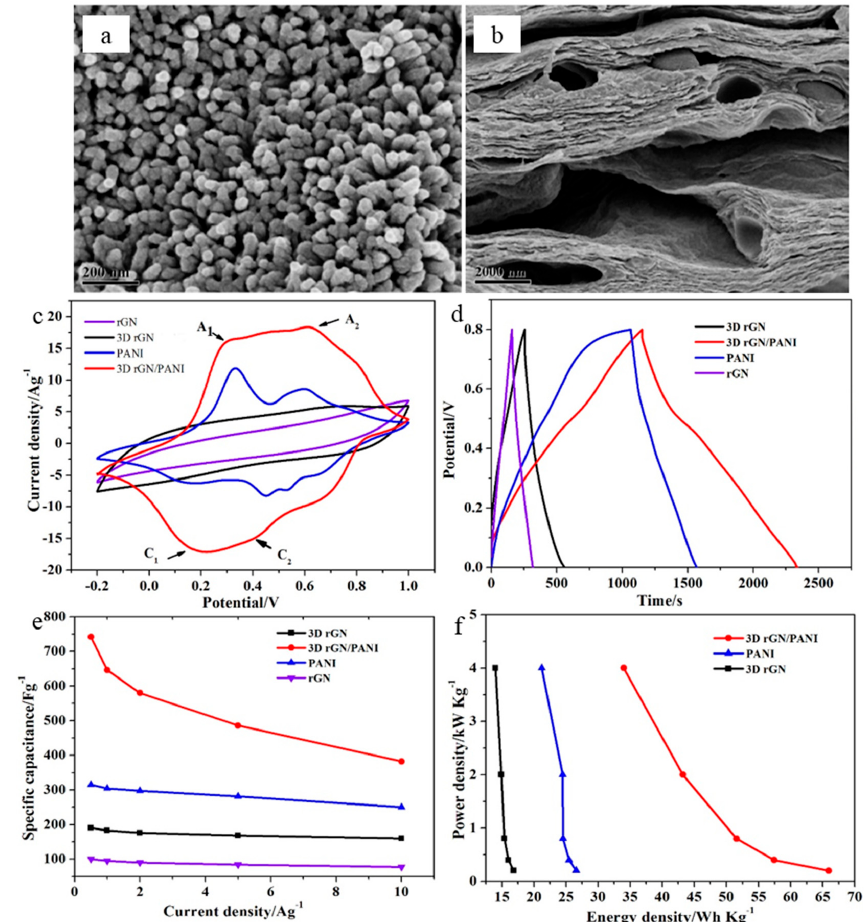
Figure 16. ( a , b ) Surface and cross-section scanning electron microscope (SEM) images of 3D / discharge curves at a current rGN/PANI film, ( c ) CV curves at 20 mV·s − 1 in 1 M·H 2 SO 4 , ( d ) Galvanostatic charge/discharge curves film, ( c ) CV curves at 20 mV · s − 1 in 1 M · H 2 SO 4 , ( d ) Galvanostatic charge density of 0.5 A · g − 1 , ( e ) Variation of the specific capacitance with current density and ( f ) Ragone plots of rGN film, 3D rGN film, PANI and 3D rGN / PANI composite film